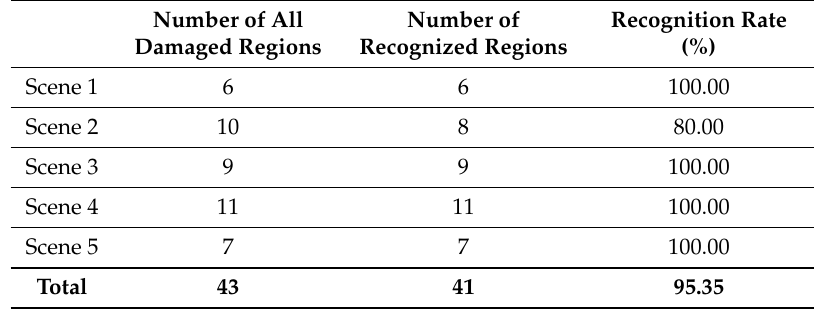
Figure 14. Final results on multiple ear damage recognition. Table 1. Summary on recognition rates for test